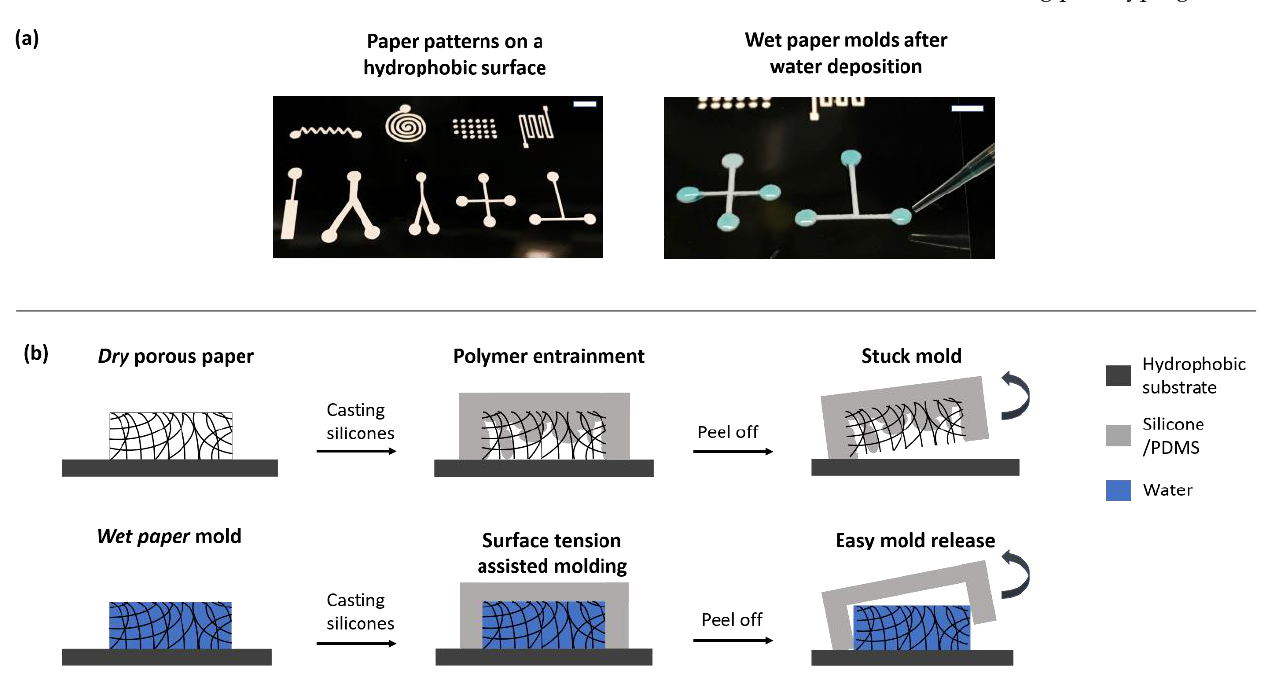
Figure 1. Replica molding of silicone/PDMS using wet paper molds. ( a ) Images showing the paper mold shapes on a transparent hydrophobic transparency paper, cut using a digital vinyl cutter. The second image shows the wet molds resulting from pipetting of appropriate amount of water followed by capillary suction from the porous paper. The scale bar for both images is 5 mm. ( b ) Conceptual schematic showing the liquid-assisted molding process. When a dry paper is used as a master mold, polymer premix enters its pores causing the mold to stuck on its surface. On the other hand, after wetting the paper, water infiltrates all the pores of the porous paper matrix. Since water is immiscible with silicones, addition of water facilitates an easier peeling off when the polymer is cured.